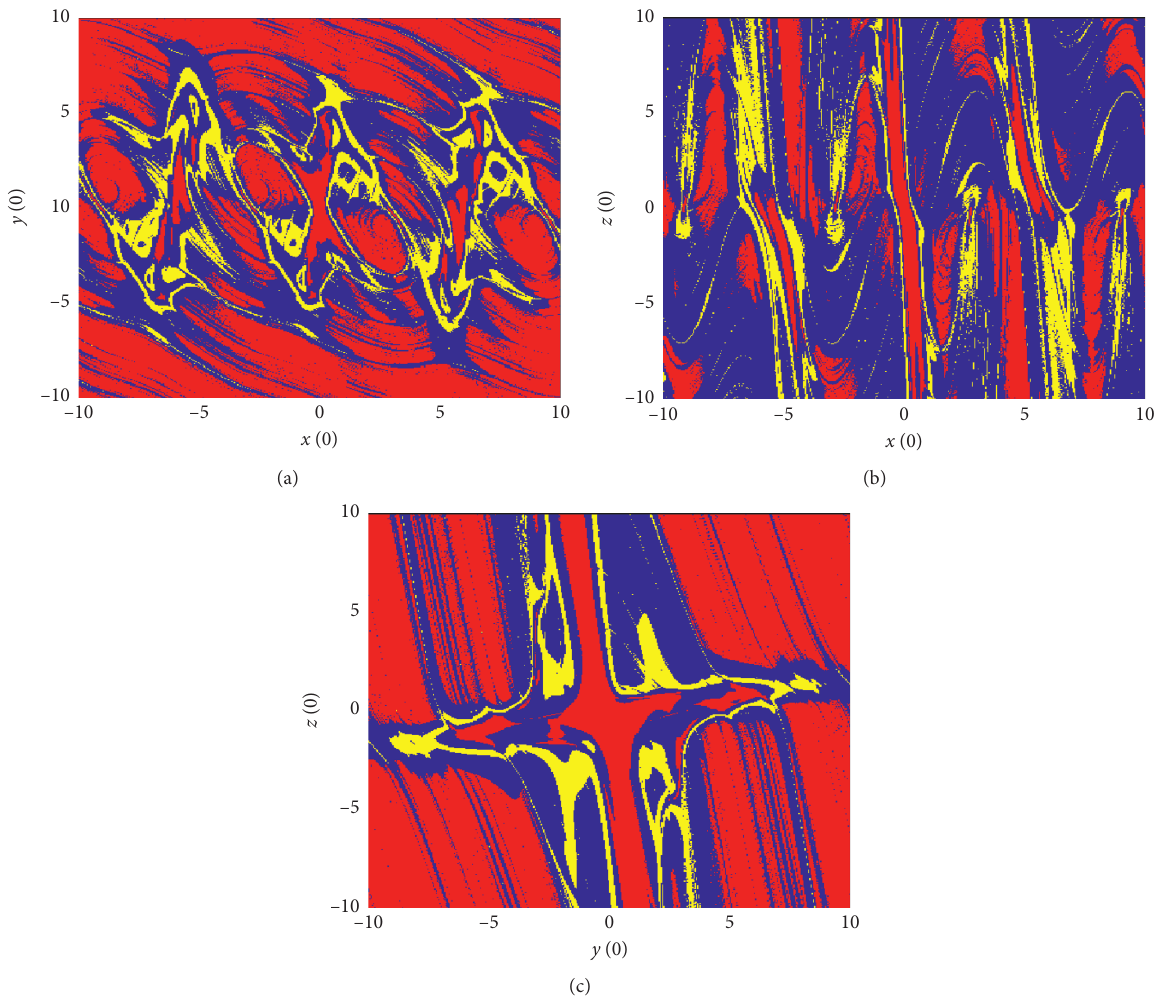
Figure 6: Basins of attraction of system (4). (a) x (0)- y (0) plane, (b) x (0)- z (0) plane, and (c) y (0)- z (0)